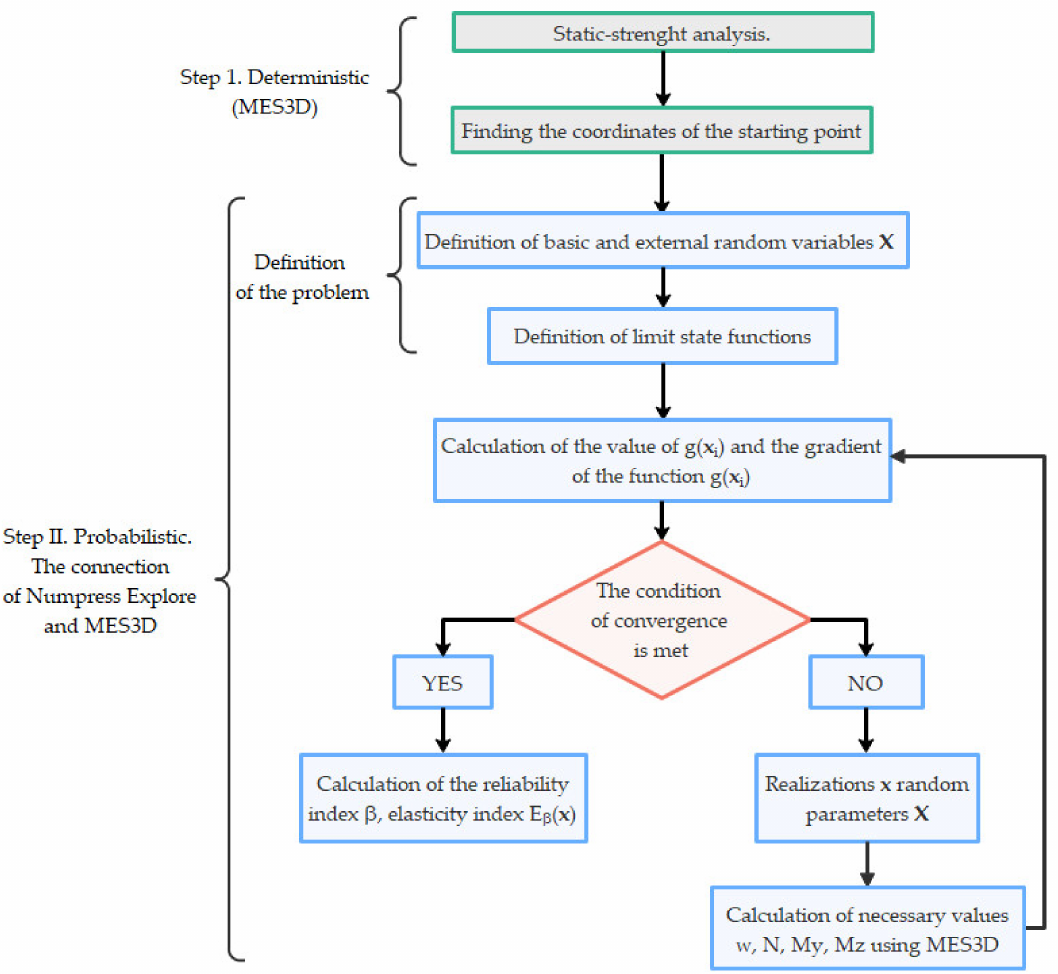
Figure 3. Cooperation between the Numpress Explore and MES3D